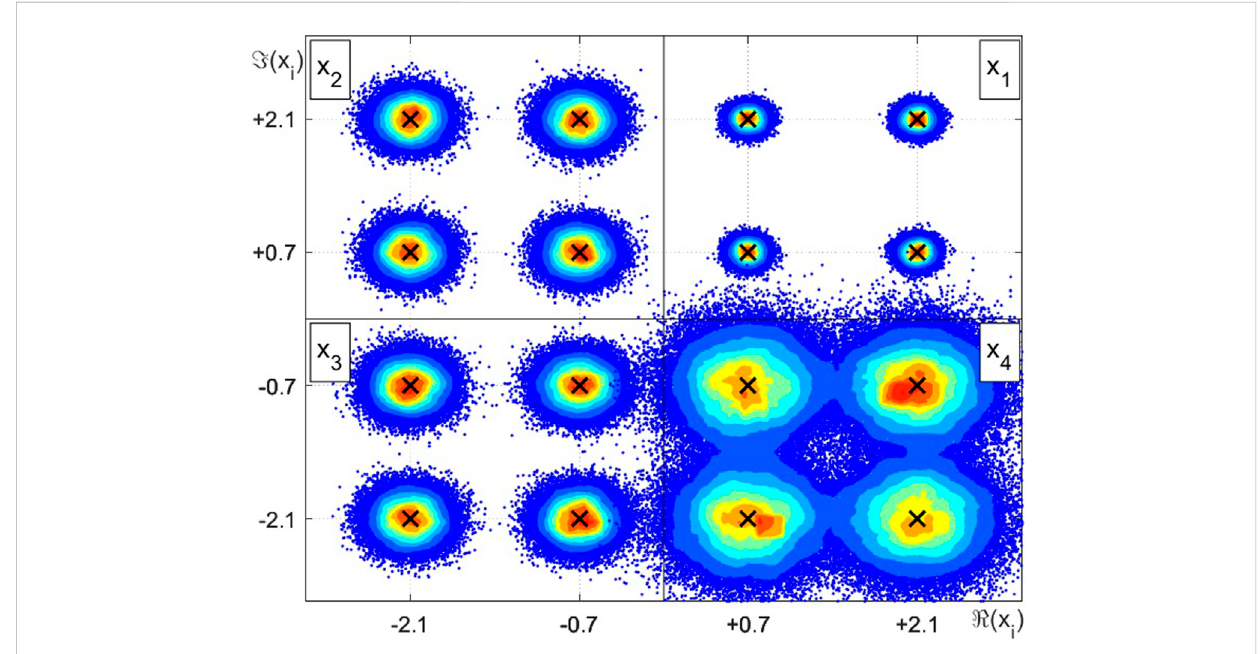
FIGURE 5 Intensity chart for the complex random variables estimation example employing CWCU LMMSE.